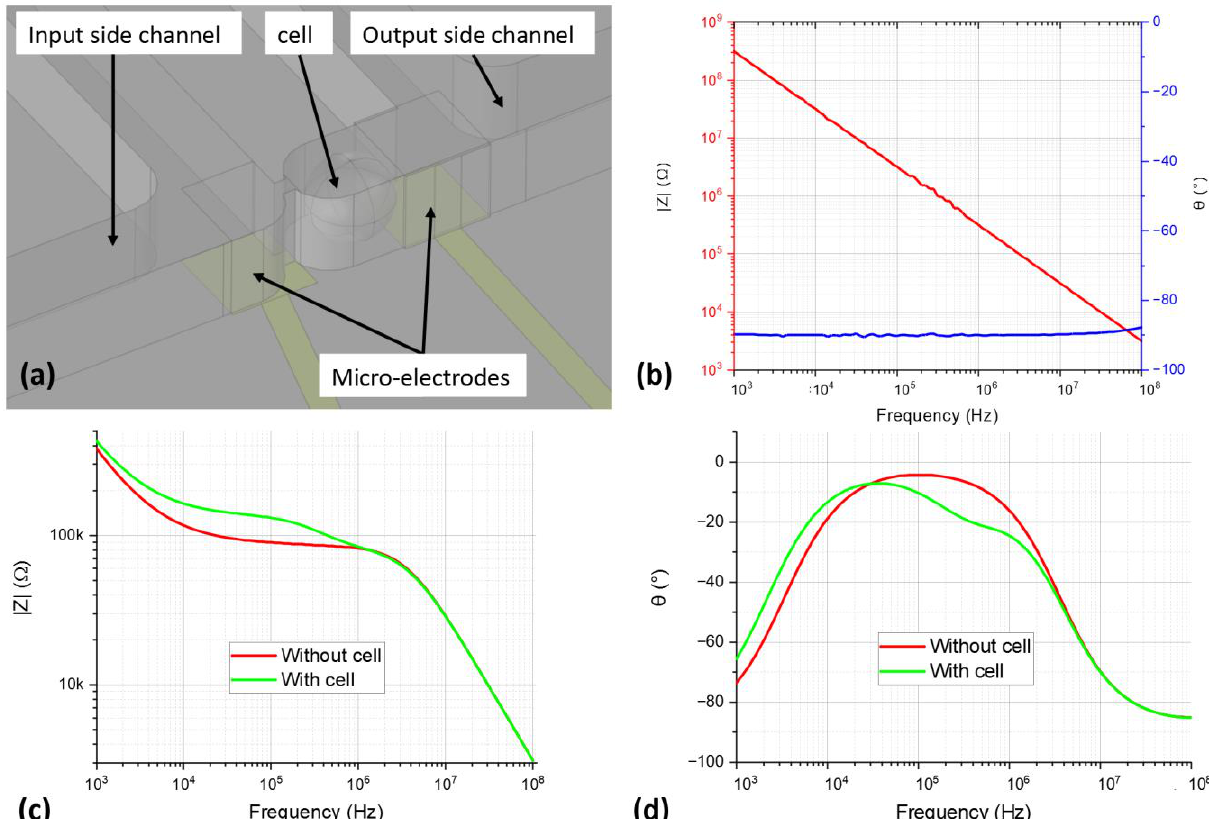
Figure 7. ( a ) A zoomed view of a 3D model of the simulated device’s trapping area with a cell model in the channel. ( b ) The impedance of a microelectrode pair in the SIM_AIR simulation. ( c ) A comparison of the impedance modulus of a microelectrode pair in the SIM_SOL and SIM_CELL simulations. ( d ) A comparison of the impedance phases of a microelectrode pair in the SIM_SOL and SIM_CELL simulations.